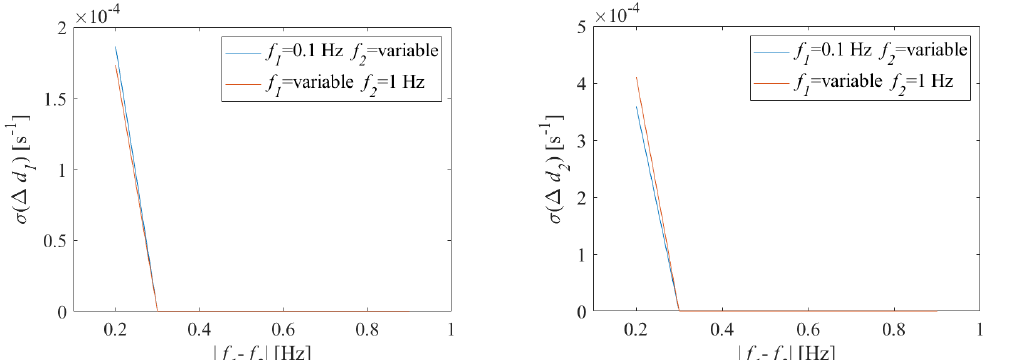
Figure 12. Standard deviation of ∆ d versus the frequency distance between the components obtained in numerical tests with noise and quantization; results for components with damping d 1 ( on the left ) and damping d 2 ( on the right